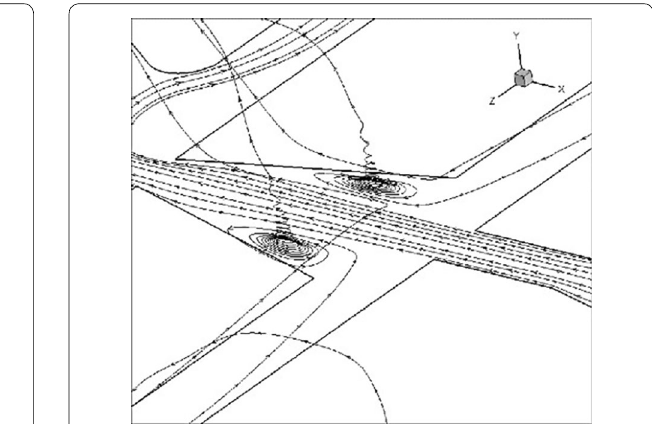
Figure 16 Velocity contour of the central section